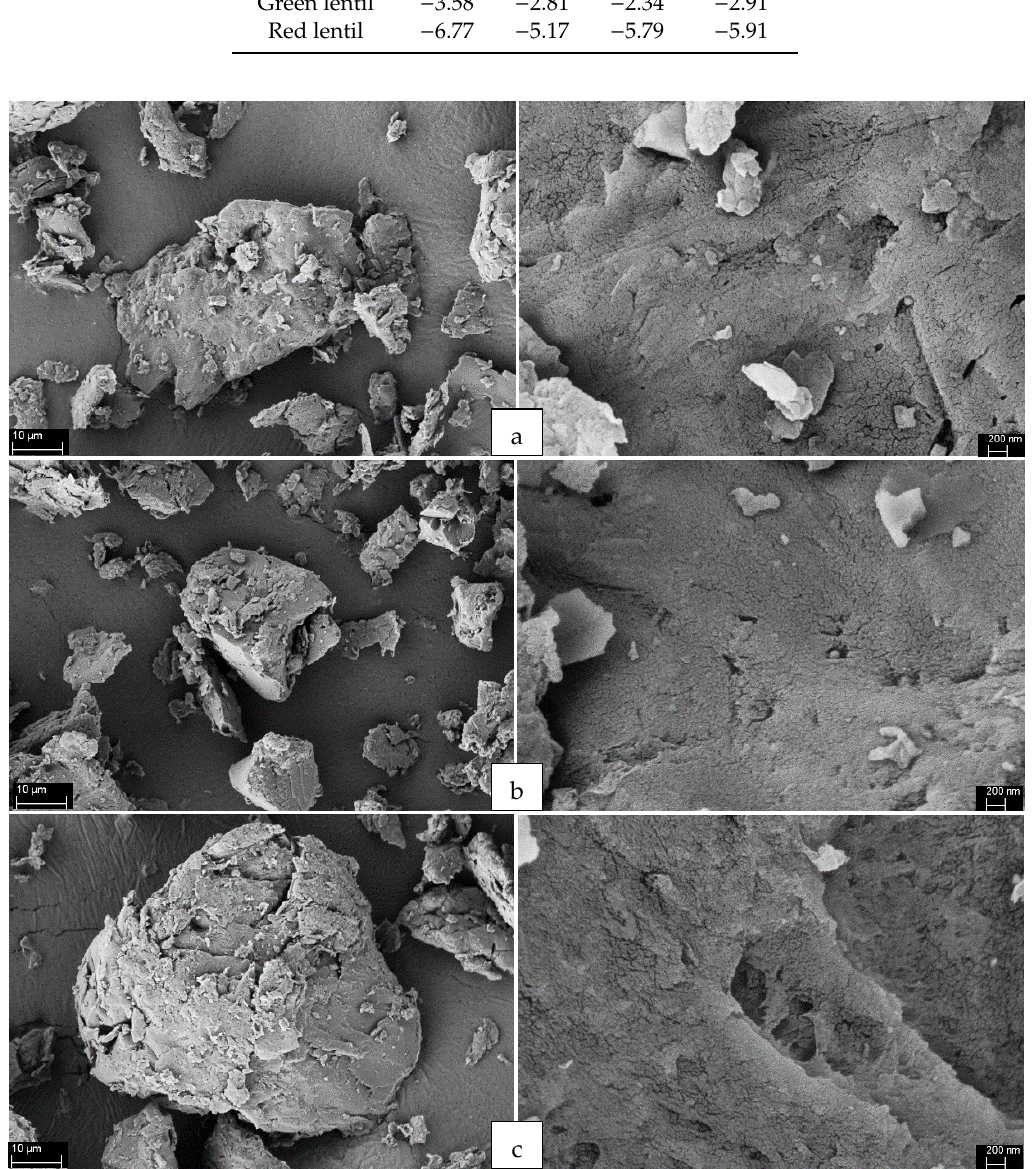
Figure 1. FESEM images of ( a ) brown lentil, ( b ) green lentil, and ( c ) red lentil at a magnification of 1000× (left) and 20,000× (right). Table 2. Energy-dispersive X-ray spectroscopy analysis of the lentils.